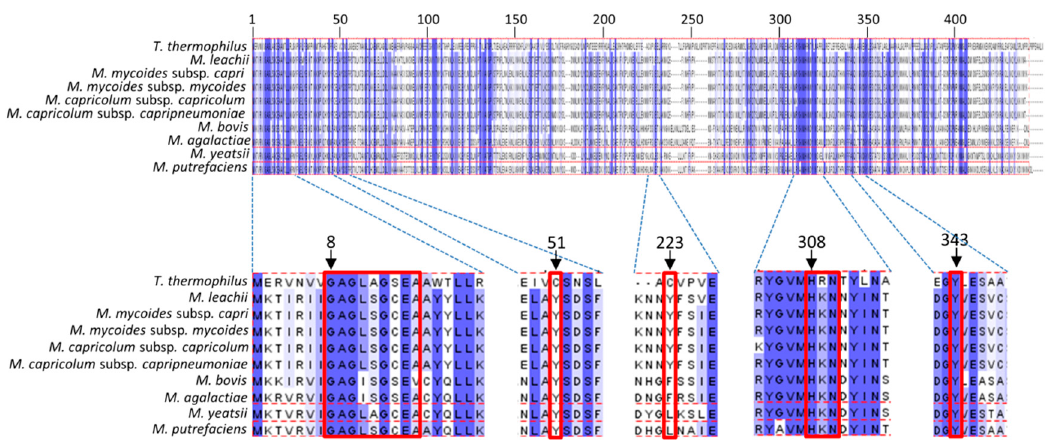
Figure 6. Structural model of TrmFO-like protein. ( A ) Structural overlay of the crystal structure of T. thermophilus TrmFO (blue) with the 3D model of M. capricolum subsp . capricolum TrmFO-like protein MCAP_0613 (red). The FAD coenzyme is represented as ball sticks in yellow. ( B ) Location of the two cysteines (top panel) that are strictly conserved and required for m 5 U54-tRNA methylation activity in